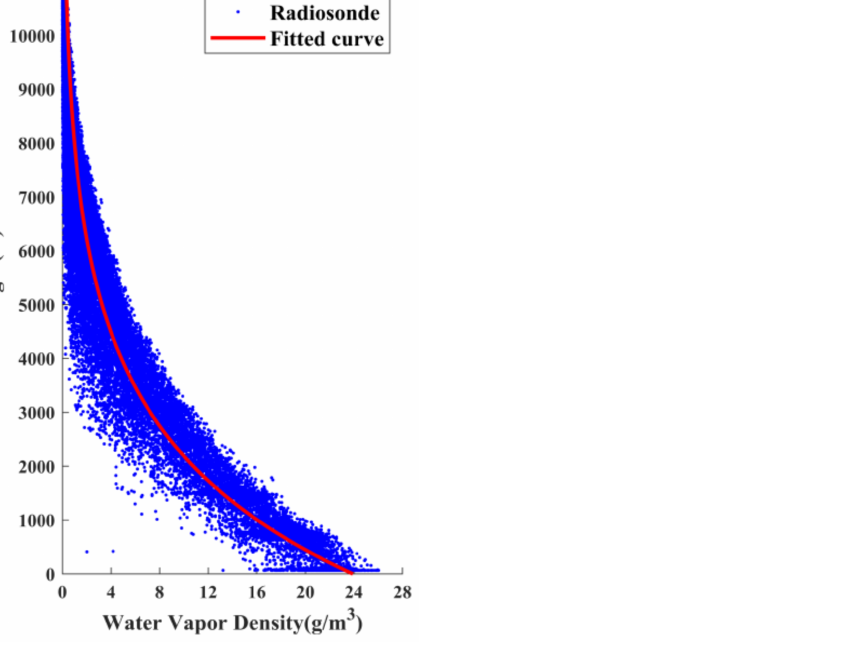
Figure 1. Fitting schematic diagram of the average radiosonde water vapor profile in the study